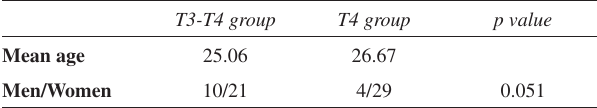
Table 1 - Clinical characteristics of the patient